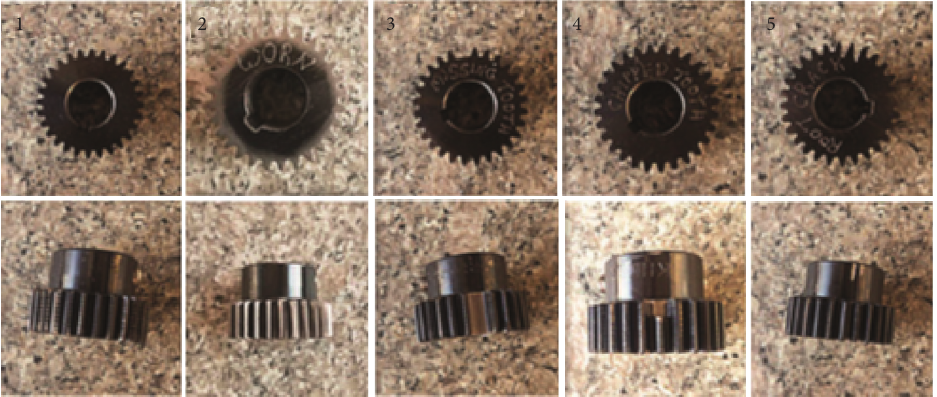
Figure 6: Five types of gears.